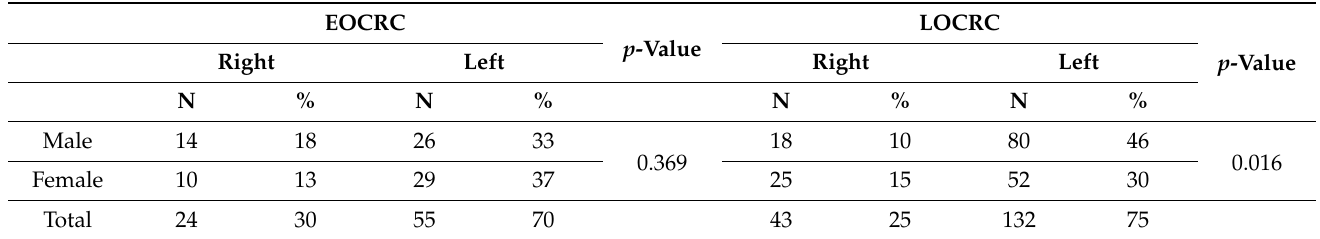
Table 5. Gender distribution according to the sidedness of CRC between the EOCRC and LOCRC groups.